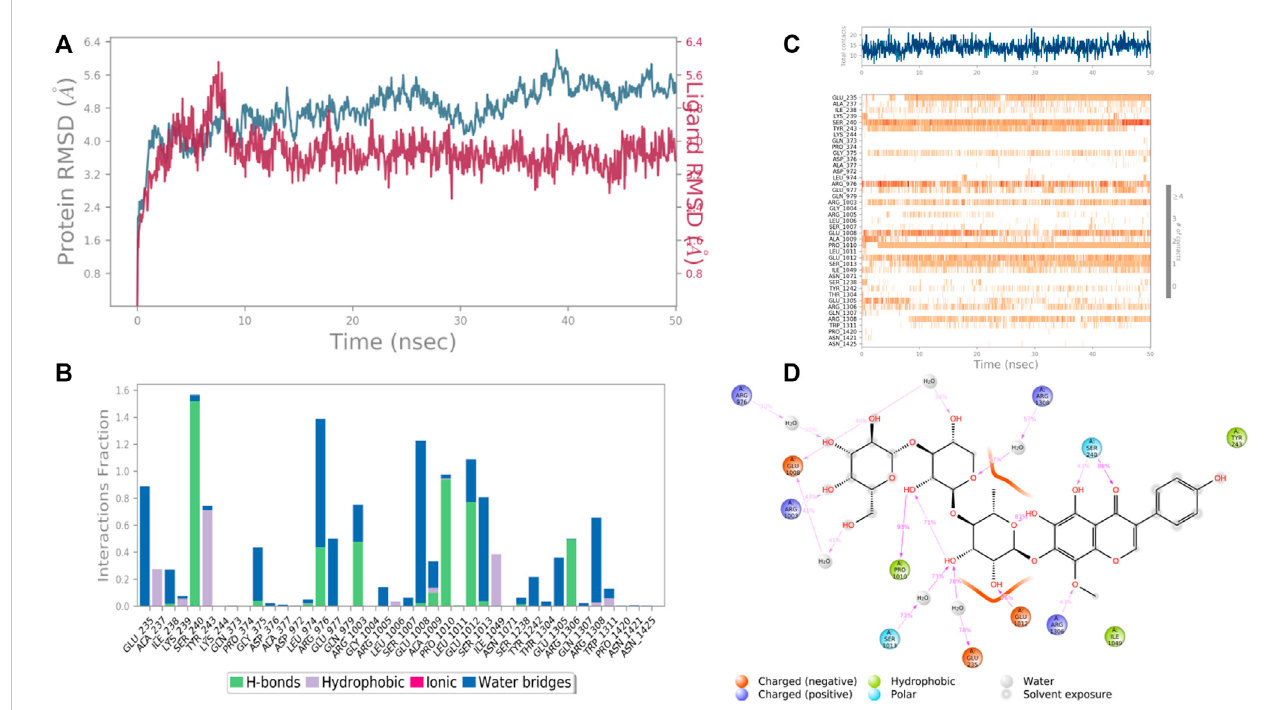
FIGURE 11 RMSD plot of the protein – ligand complex UDP glucose:glycoprotein glucosyltransferase 2 (Gene: UGGT2) (AlphaFold) (A) , Protein-ligand contacts (B) , stackedbarplotofthefractionoftimeoftheinteractions (C) andLigand-Proteincontacts (D) ofanalogue4 ′ ,5,6,7-Tetrahydroxy-8-methoxyiso fl avone-7-O- beta-D-galactopyranosyl-(1 → 3)-O-beta-D-xylopyranosyl-(1 → 4)- O-alpha-L-rhamnopyranoside for 50 ns of simulation time.